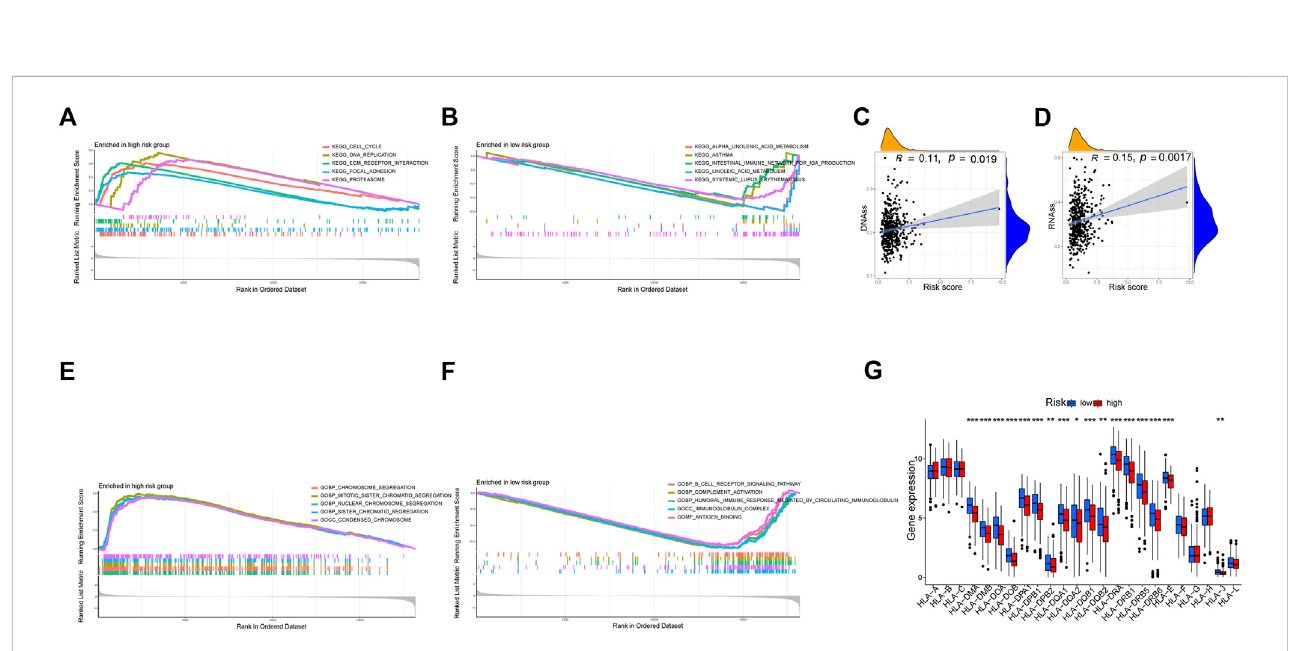
FIGURE 11 Explorationofpossiblereasonsfordifferencesbetweenhighandlow-riskgroups. (A,B) KEGGEnrichmentAnalysis. (C,D) Tumorstemcellanalysis. (E,F) GO Enrichment Analysis. (G) Expression of HLA. * p < 0.05, ** p < 0.01, *** p <